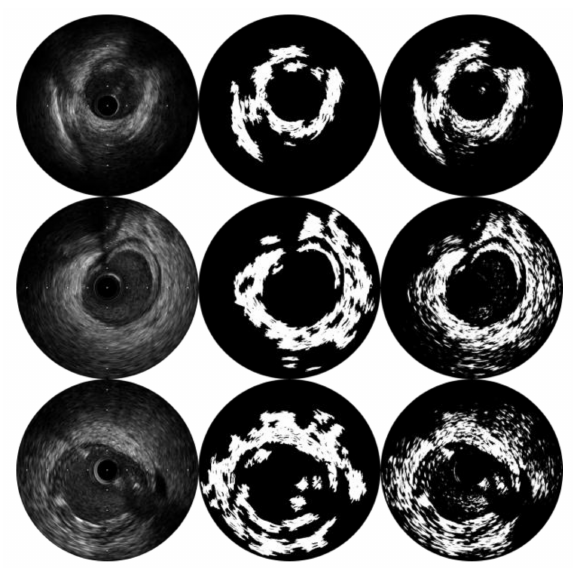
Figure 9. Comparison of the clustering results from SFCME (the second column) and pixel-wise fuzzy c-means with spatial information (the third column).